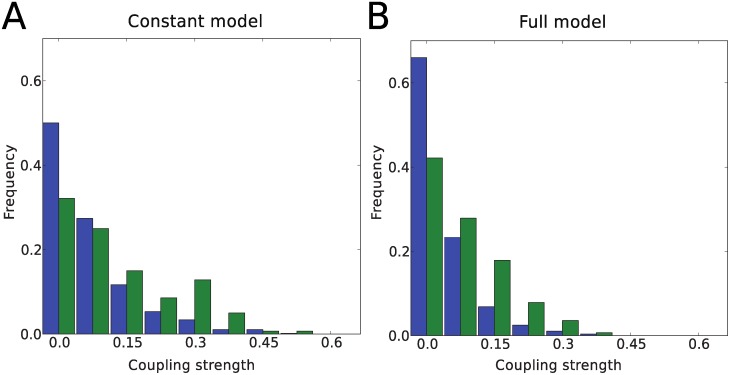
Couplings between and within modules.Both couplings between and within modules have a mean value very close to zero. The probability of the absolute value of the couplings for the model with constant (A) and full (B) fields are shown here. For the between module couplings (blue bars) there is a bigger peak at zero compared to the within module couplings (green bars), and the green histogram has bigger mass at larger values.